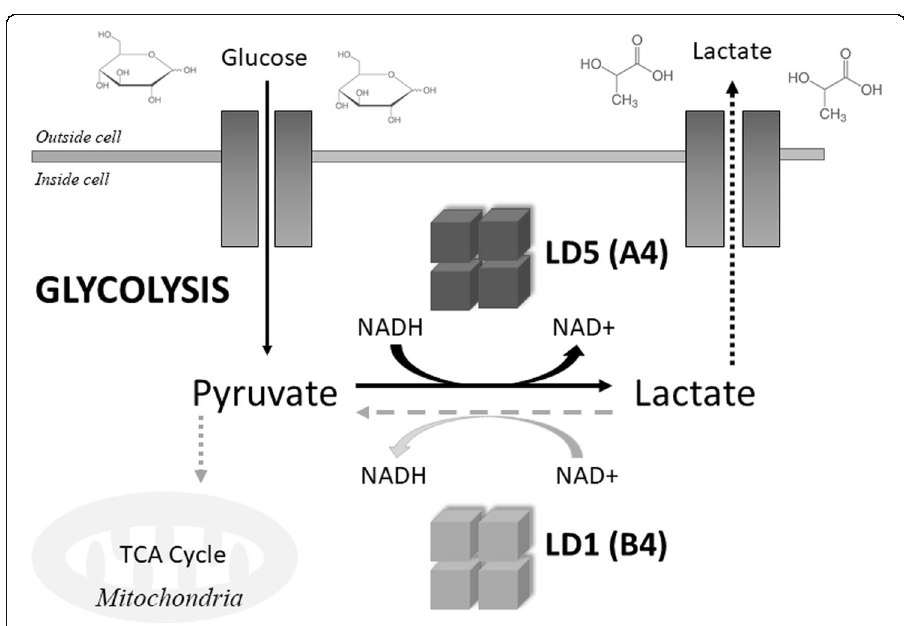
Fig. 2 Scheme presenting LDH isoforms. The ldha and ldhb genes encode LDHA and LDHB polypeptide subunits. The combinations of these two subunits into active tetramers results in the five LDH isoforms B4, A1B3, A2B2, A3B1 and A4, named LD1 to LD5, respectively. A third type of LDH subunit, known as C, is encoded by the ldhc gene. The LDHC subunit assembles only into homotetramers to form the LD6 (or LDX) isoform. The multiplicity of LDH molecular forms can be revealed on the basis of their different mobility in gel electrophoresis. The LD1 isoform has the highest and LD5 the lowest migration rate towards the anode, as demonstrated in